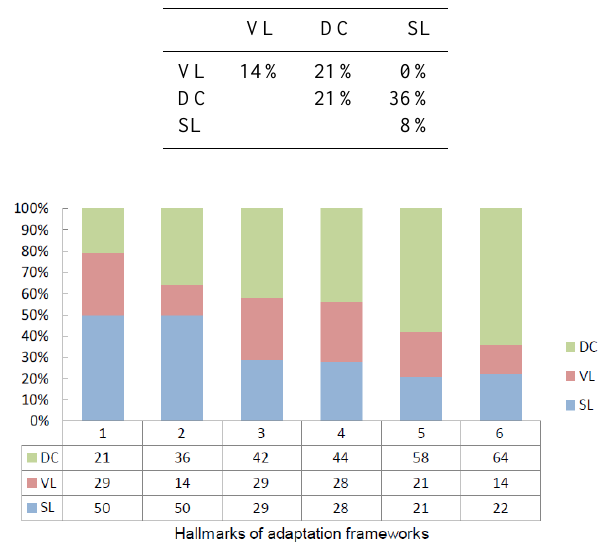
Table 1. Percentage usage of climate change adaptation frameworks in the nuclear neighbourhood.